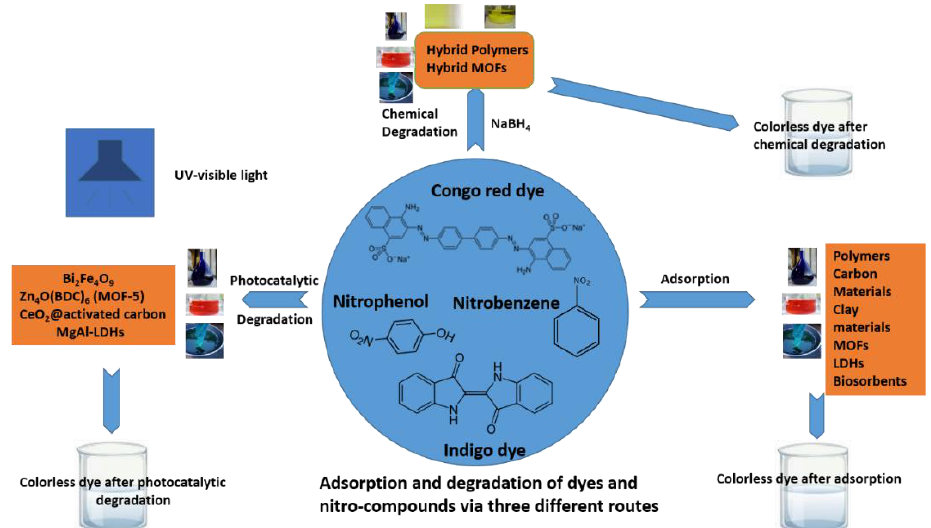
Figure 1. Graphical representation of adsorption, photocatalytic degradation, and chemical degrada- tion of dyes and nitro-compounds using different